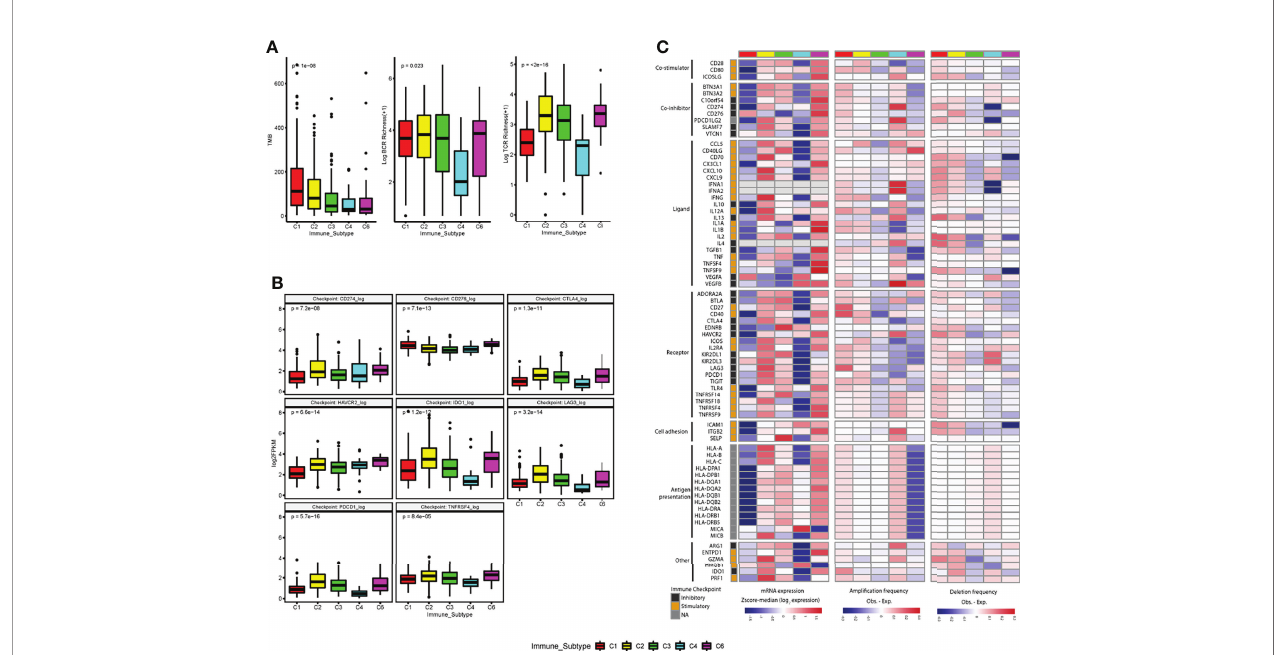
FIGURE 6 | Regulation of immunomodulators. (A) The tumor immunogenicity (tumor mutational burden (TMB) and immune receptor repertoire (BCR and TCR diversity (log+1 transformed) are different across immune subtypes. (B) Distribution of expression levels for immune checkpoints (log2 FPKM) by immune subtypes. (C) Immune subtypes show differential expression of immunomodulatory genes. mRNA expression (log2FPKM), ampli fi cation frequency (difference between the observed versus the expected fraction of samples in which an IM is ampli fi ed), and deletion frequency (difference between the observed versus the expected fraction of samples in which an IM is deleted) for 75 immunomodulator genes by immune subtype. P-value was calculated by the Kruskal-Wallis test for immune checkpoints, TMB, BCR, and TCR